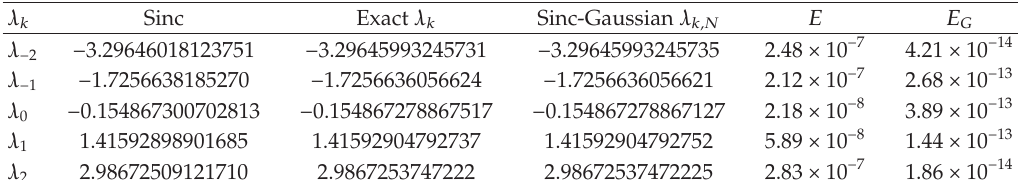
Table 3: The absolute errors of sinc-Gaussian and the classical sinc-method with N (cid:7) 20, h (cid:7) 0 . 3, ω (cid:7) 1 .